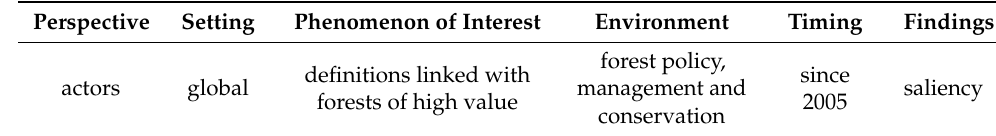
Table 1. Components of the study